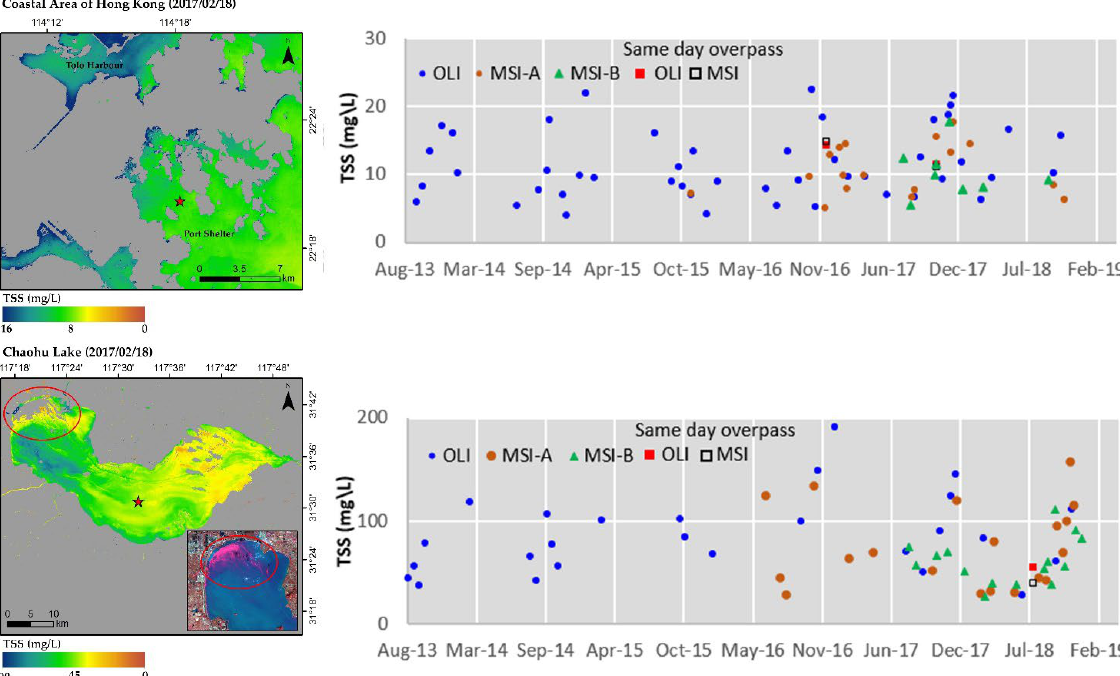
Figure 4. TSS concentration together with the time series plot of an arbitrary location (indicated by the star symbol in maps) in the coastal area of Hong Kong and at Lake Chaohu. Blue dots, brown dots, and green triangles show the TSS derived by the Landsat-8 OLI and Sentinel-2 MSI A/B, respectively. The same-day OLI and MSI overpasses are shown by the red square and the black hollow